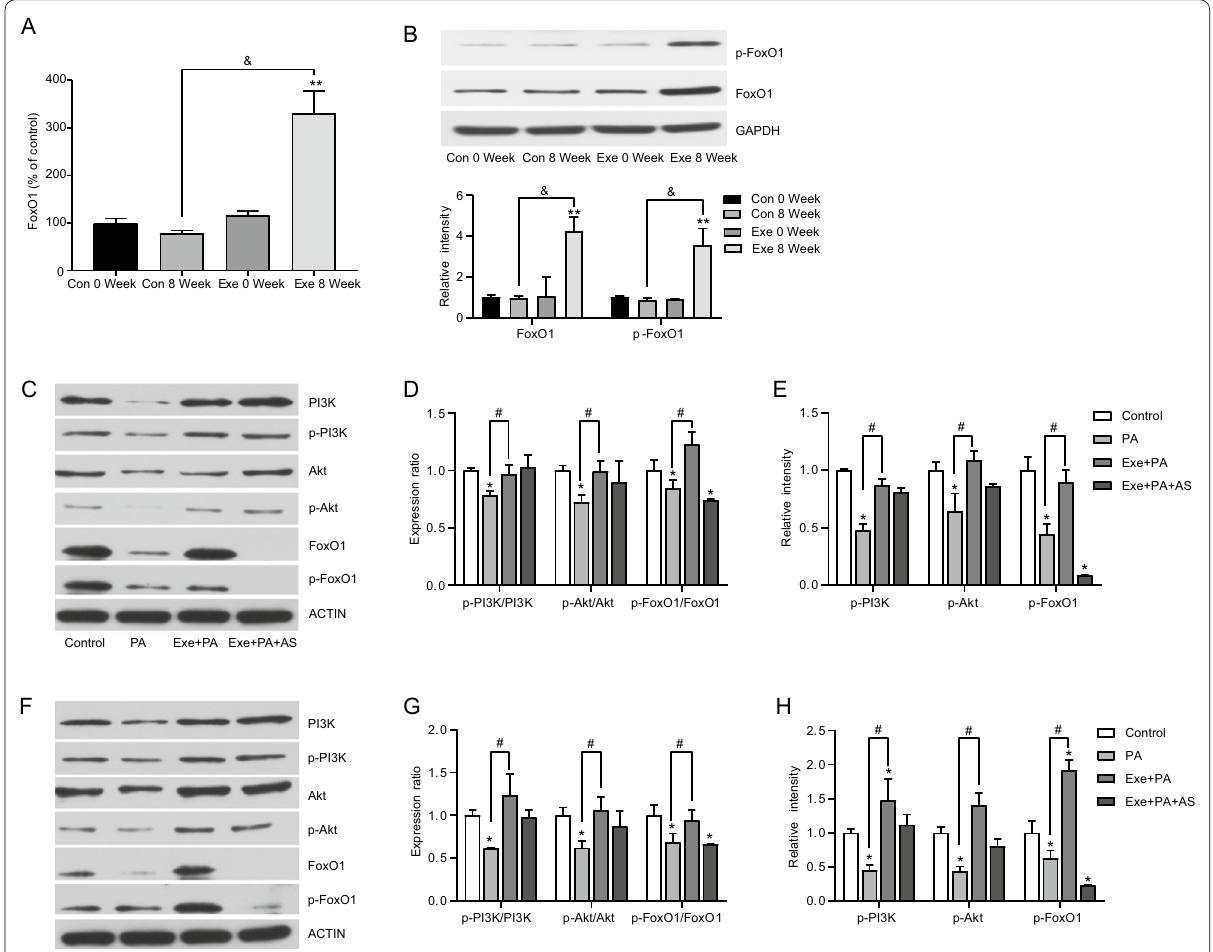
Fig. 5 Effects of exenatide on Th17/Treg proliferation via PI3K/Akt/FoxO1 signaling. A mRNA levels of FoxO1 in PBMCs from control (Con) and exenatide (Exe) groups detected by real-time PCR. mRNA quantities were calculated as a ratio to the level of GAPDH mRNA in each sample. Data are shown as the relative expression ratio to Con 0 Week. Results are expressed as mean SEM, n 8 in each group. B Representative image and gray ± = value analysis of Foxo1 and phosphor (p)-FoxO1 in PBMCs from Con and Exe groups detected by western blot. ACTIN was used as a loading control. Data are shown as the relative expression ratio to Con 0 Week and expressed as mean SEM, n 8 in each group. C Th17 cells were treated with ± = palmitate (PA), exenatide plus palmitate (Exe PA) and exenatide, palmitate plus FxoO1 inhibitor AS1842856 (Exe PA AS). Representative image + + + of total PI3K, Akt, FoxO1 and p-PI3K, p-Akt, p-FoxO1 in Th17 cells in vitro detected by western blot. D Gray value analysis of p-PI3K/PI3K, p-Akt/Akt and p-FoxO1/FoxO1 in Th17 cells. E Gray value analysis of p-PI3K, p-Akt and p-FoxO1 in Th17 cells. F Treg cells were treated with PA, Exe PA and + Exe PA AS. Representative image of total PI3K, Akt, FoxO1 and p-PI3K, p-Akt, p-FoxO1 in Treg cells in vitro detected by western blot. G Gray value + + analysis of p-PI3K/PI3K, p-Akt/Akt and p-FoxO1/FoxO1 in Treg cells. H Gray value analysis of p-PI3K, p-Akt and p-FoxO1 in Treg cells. Data are shown as the relative expression ratio to Control. Three independent experiments were performed and results are expressed as mean SEM. ** P < 0.01, ± * P < 0.05 vs control 0 week ( A , B ), or control group ( D , E , G , H ); & P < 0.01, # P < 0.05 vs control 8 week ( A , B ), or PA group ( D , E , G , H ); ns P >